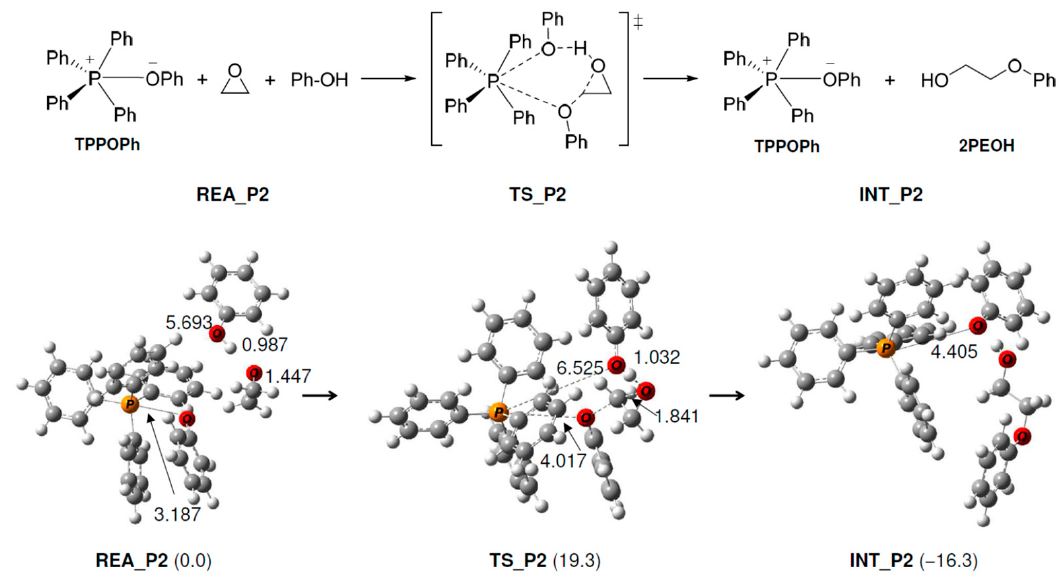
Figure 3. Geometry and free energy changes in the phenol–epoxy ring-opening reaction using TPP-OPh. The bond lengths are in Å. Relative free energies (kcal/mol) to REA_P2 are in parentheses.